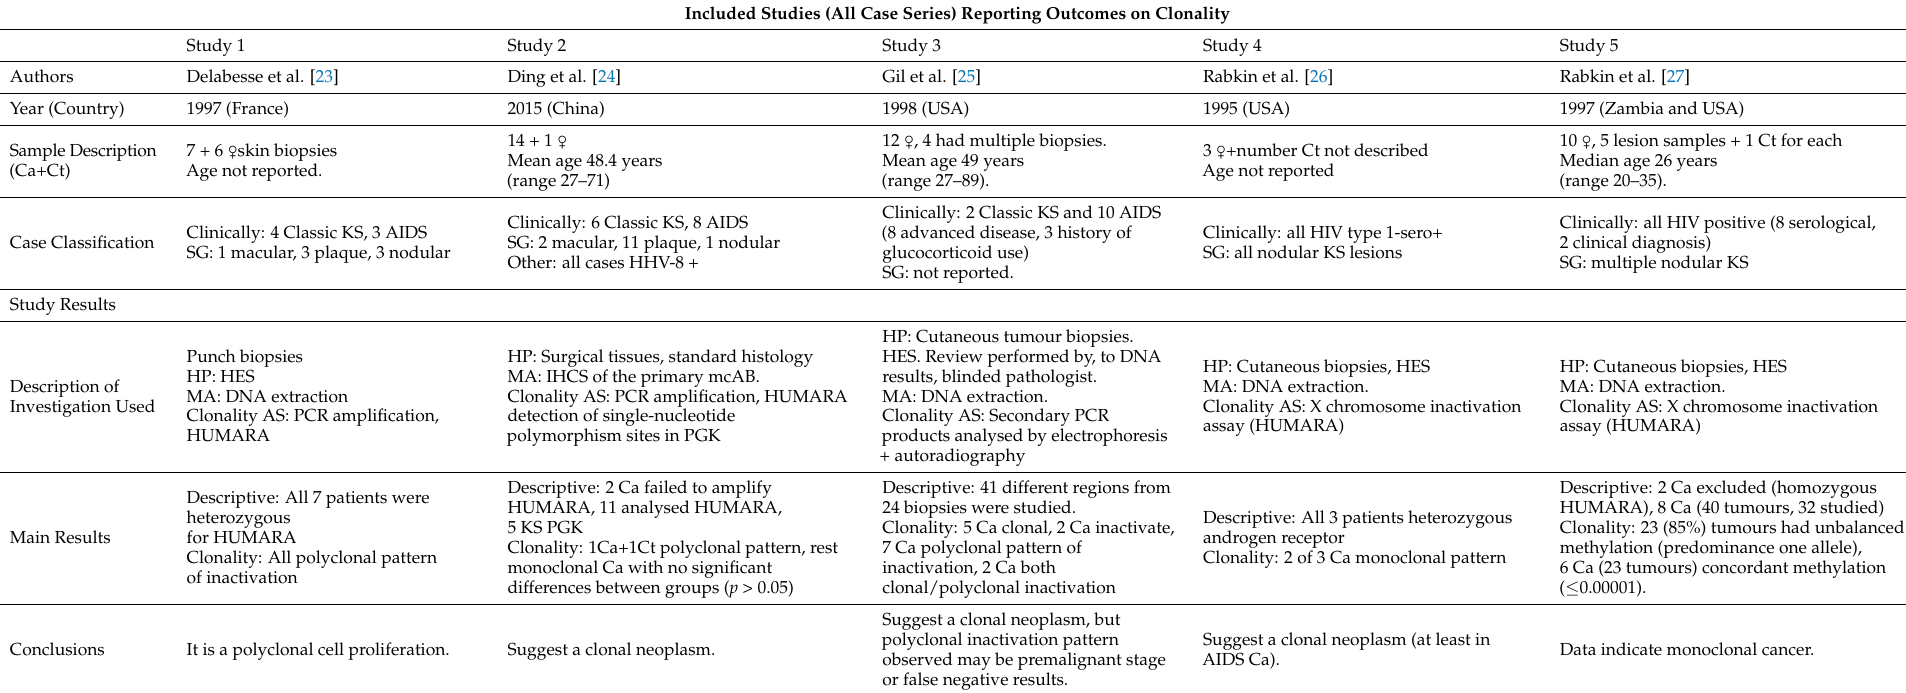
Table 2. Summary of findings: studies reporting on